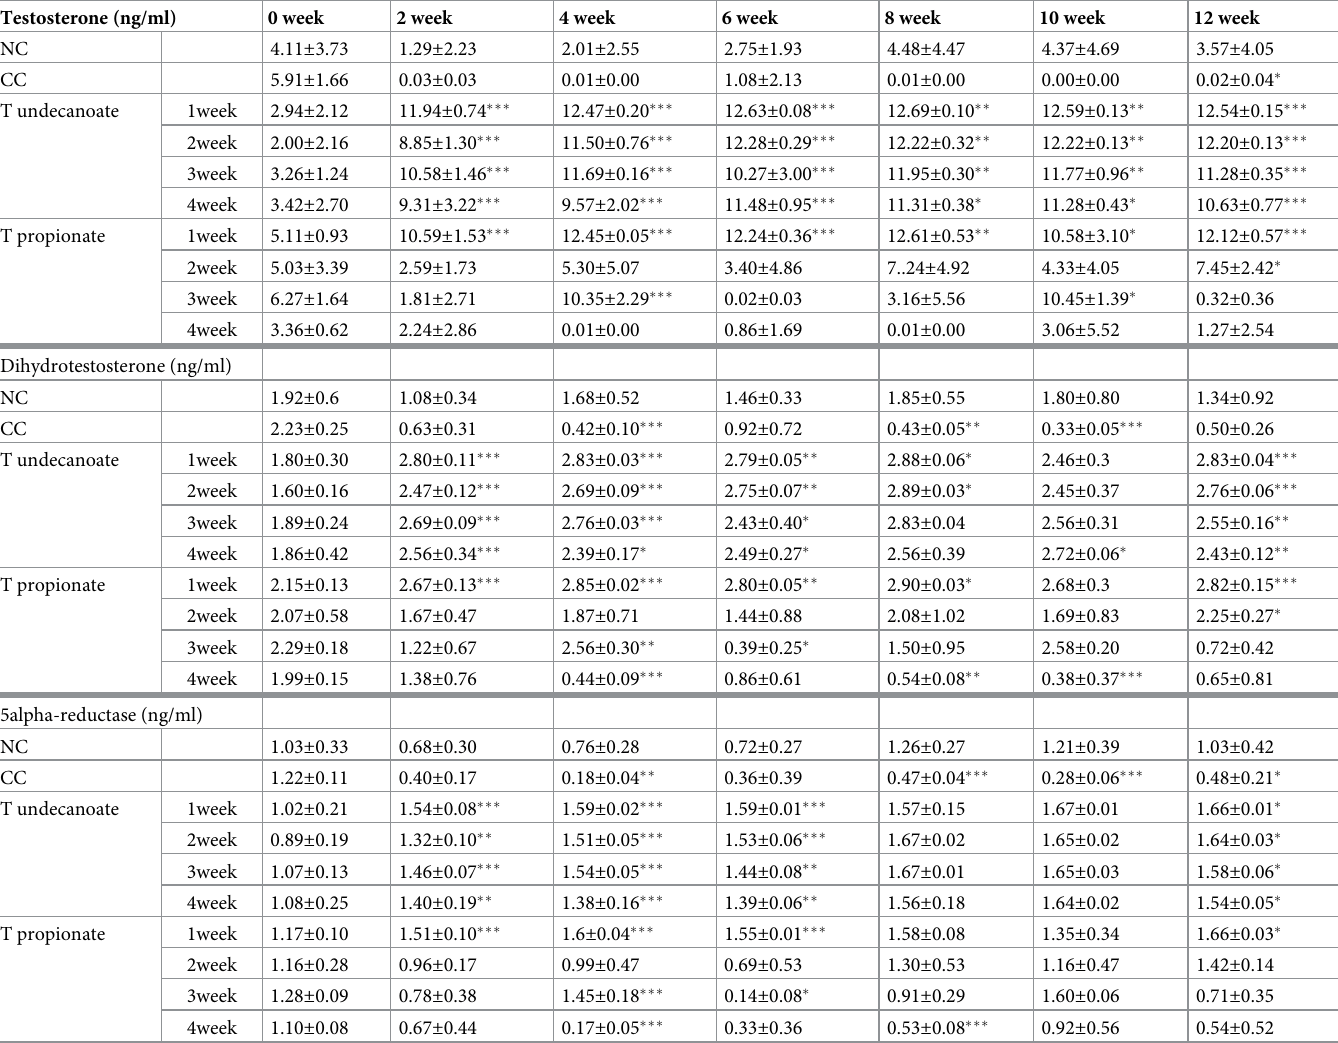
Table 2. Changes in serum levels of testosterone, dihydrotestosterone, and 5-alpha reductase in the injection cycle